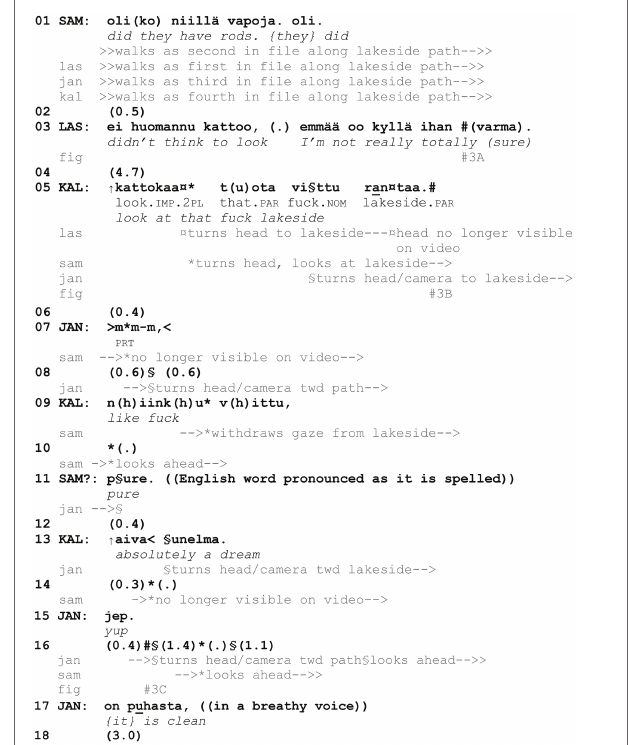
FIGURE 2 | Risto looks at and points to the anthill but remains at some distance from it; grandfather assists Väinö in getting up (A) . Risto points to the anthill but looks at grandfather; grandfather looks at the anthill (B) . EXAMPLE 3 | 42COACT Salami buddy 6